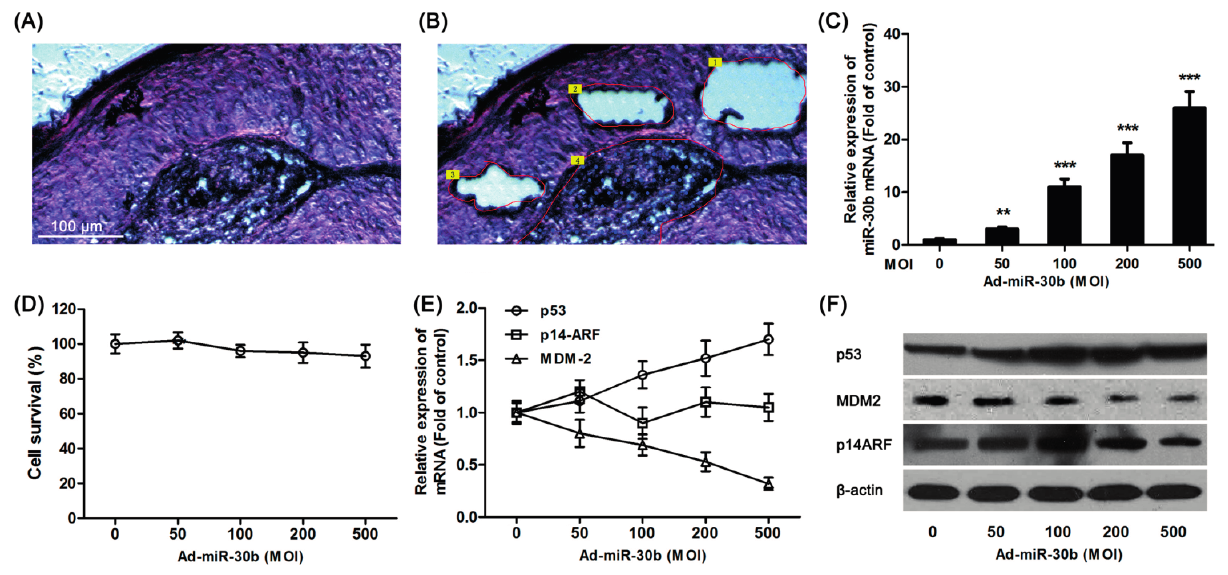
Figure 1. Overexpression of miR-30b regulated p53 expression. ( A ) Hematoxylin and eosin (H&E) staining of laryngeal carcinoma sections; ( B ) Using LCM (laser capture microdissection), sections were divided into center area (Area 4) paracancerous (paraneoplastic distance <5 mm, Area 1–3) and surgical margins (paraneoplastic distance >10 mm, not shown) by LCM. Scale bar = 100 μ m and referred to ( A ) and ( B ) panels; ( C ) After HEp-2 cells were incubated with miR-30-lentivirus vector for 16 h in different multiplicity of infection (MOI), the expression of miR-30b was determined using qRT-PCR. ** p < 0.01, *** p < 0.001 compared to control group, n = 6; ( D ) After infected by miR-30-lentivirus vector for 16 h, HEp-2 cell viability was detected by ( E ) After infected, the mRNA expression level of p53 , MDM-2 and p14-ARF were investigated using qRT-PCR; and ( F ) The expression of p53, MDM-2 and p14-ARF in protein level were detected by western blot after infected. All experiments were repeated at least three